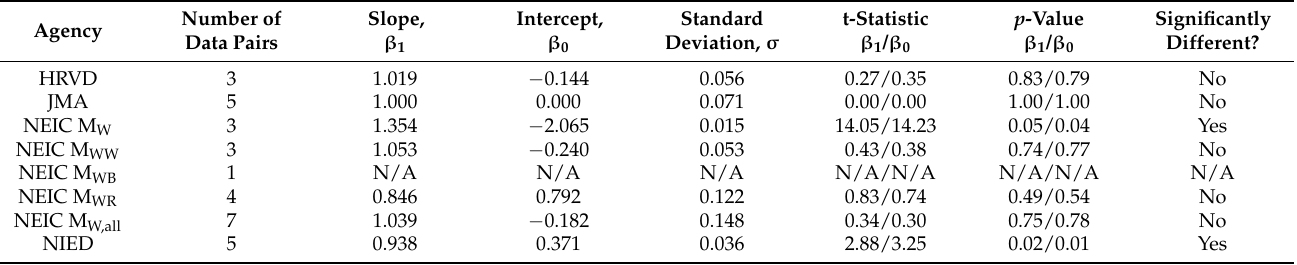
Table 8. Hypothesis testing results against a M W pool from GCMT and ISC-GEM for the South Korean catalog. Significance level α =